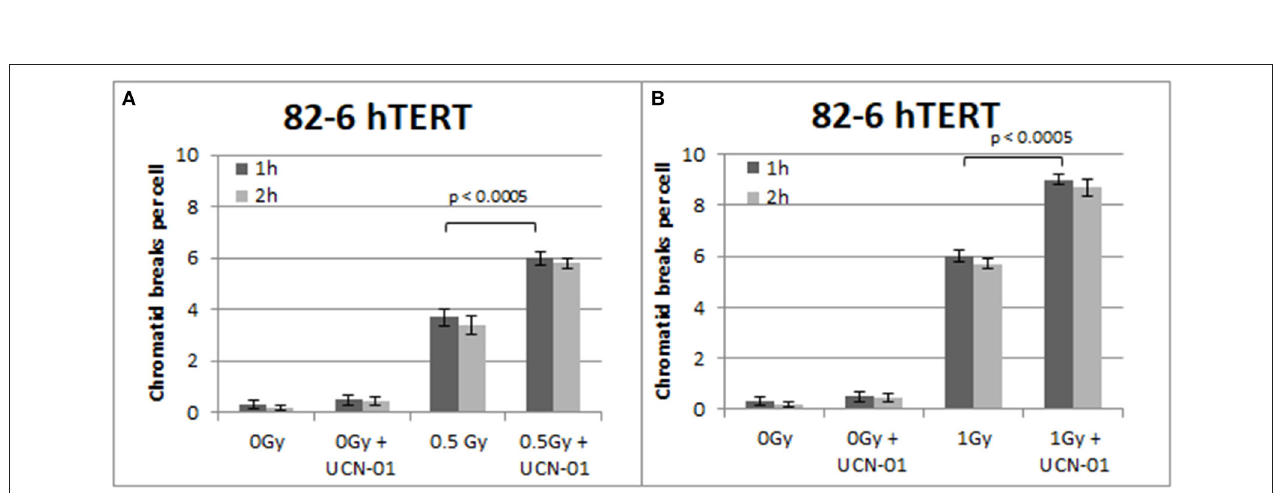
FIGURE 4 | (A) Yield of chromatid breaks in the 82-6 hTERT cells, treated with UCN-01, or left untreated, following exposure to 0.5Gy. (B) As in (A) after exposure to 1Gy. Other details as in Figure 2 (Mean ± SD based on three independent experiments; statistically significance criterion: p ≤ 0.05).